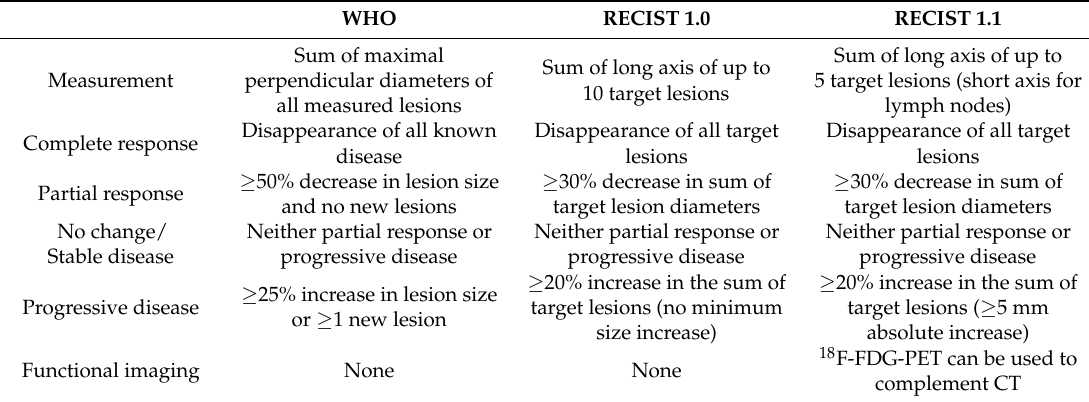
Table 1. Comparison between the most frequently used imaging response criteria.